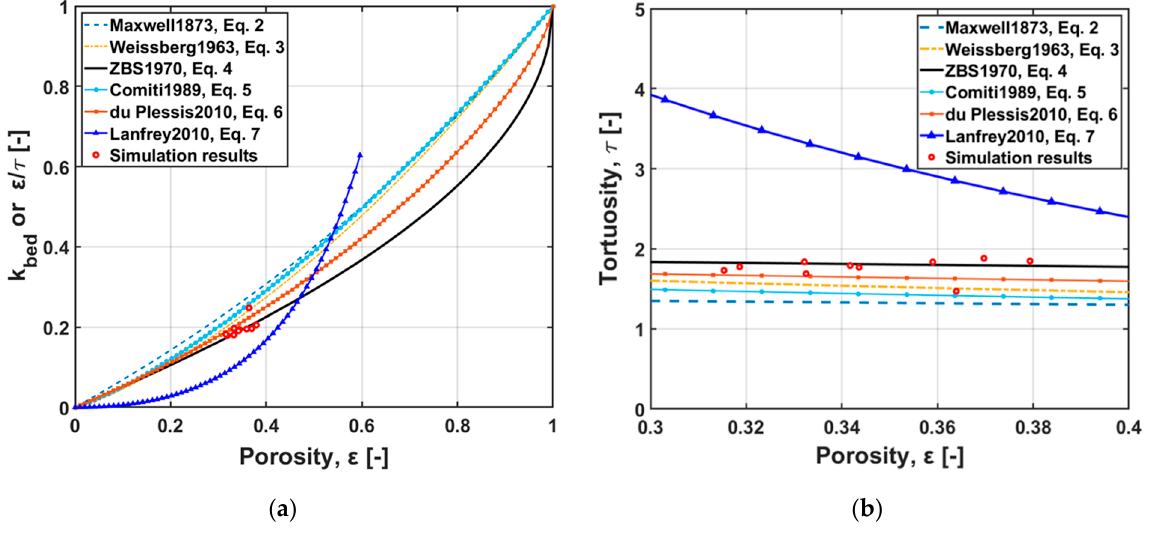
Figure 6. Comparison of simulated results with prediction models: Equation (2) [34]; Equation (3) [36]; Equation (4) [47]; Equation (5) [39] with C = 0.63 for cubes; Equation (7) [46] with φ = 0.806 for cubes; and Equation (6) [41]. ( a ) Effective residual thermal conductivity or effective diffusivity and ( b ) tortuosity.